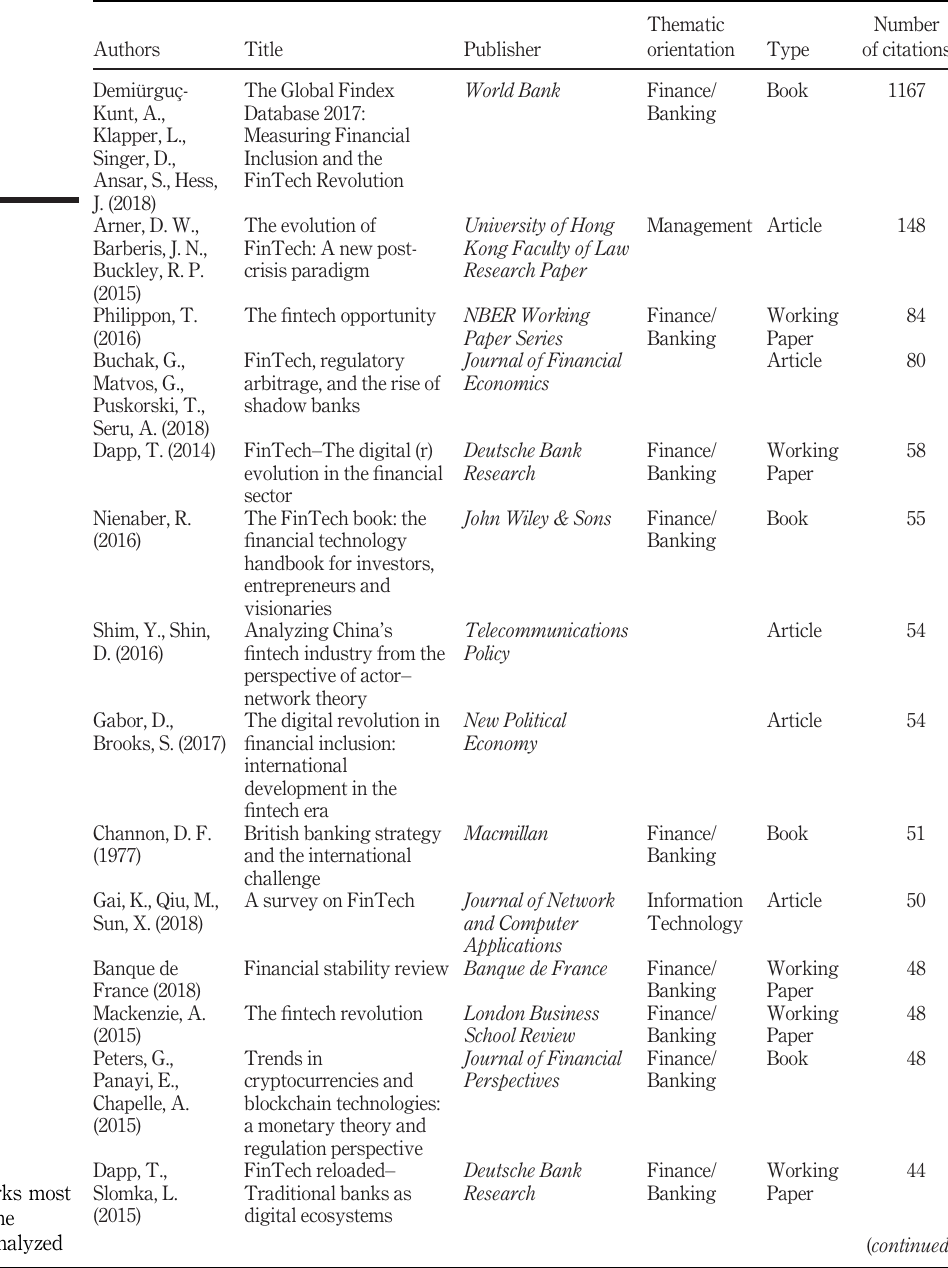
evident in the databases